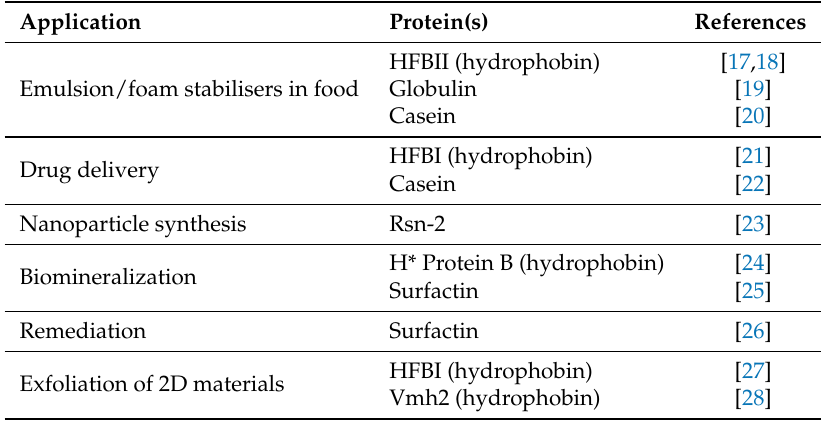
Figure 1. Schematic illustration of common biological functions of biosurfactants. ( a ) formation of interfacial layer to assist growth of aerial bodies; ( b ) formation of surface layer aiding cell attachment and growth; ( c ) membrane adsorption and poration. Table 1. Examples of investigated applications for protein